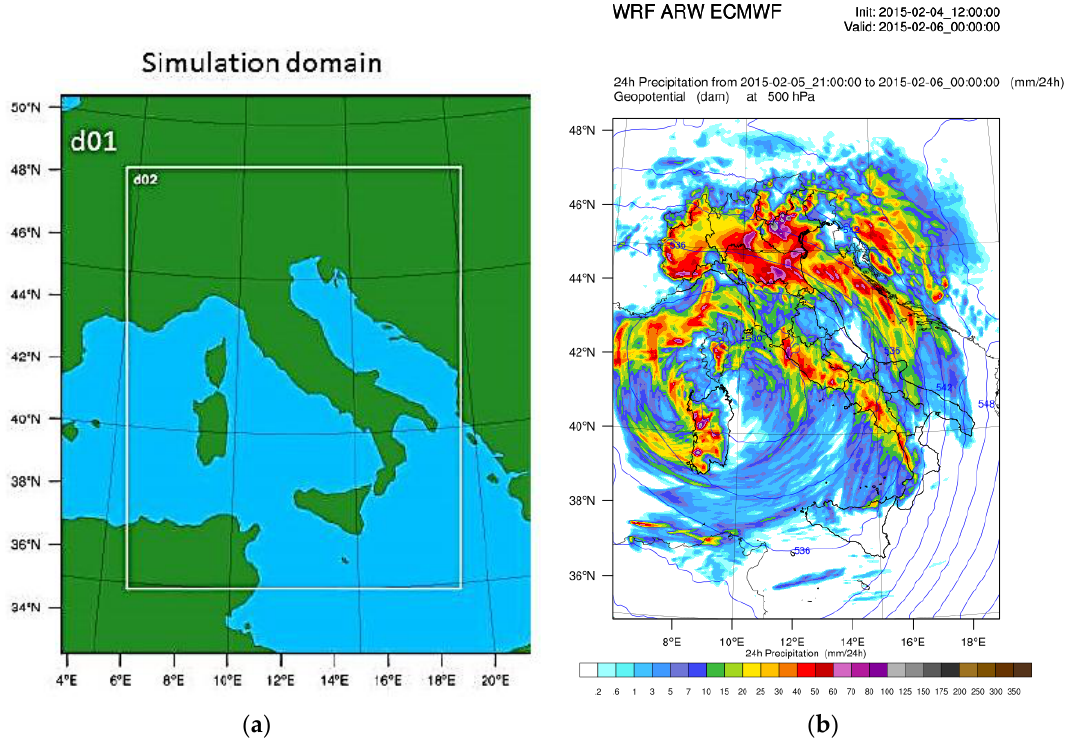
Figure 2. Weather data sources: ( a ) Schematic representation of nested domains (d01, d02) for the two Numerical Weather Prediction models (NWP), WRF-ARW and RAMS; ( b ) WRF-ARW simulation of the total equivalent of cumulated precipitation in a wet snow event occurred in February 2015 in the North of Italy.